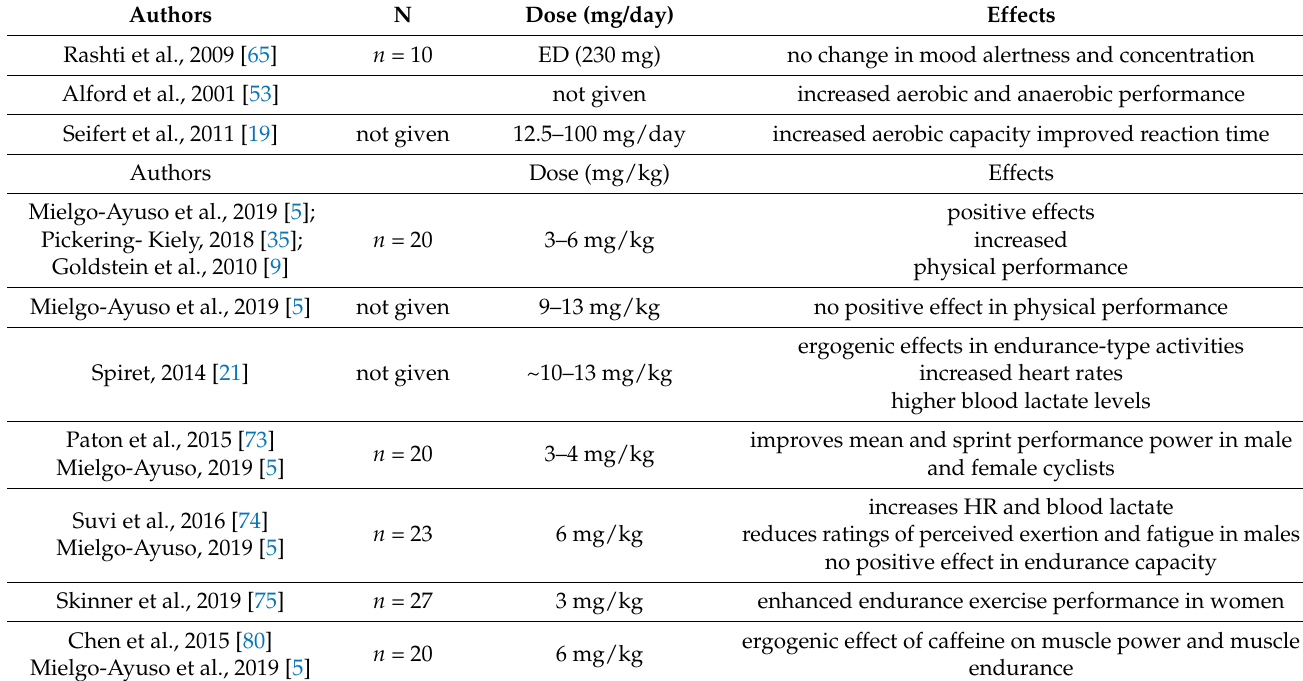
Table 2. Effects of EDs in physical